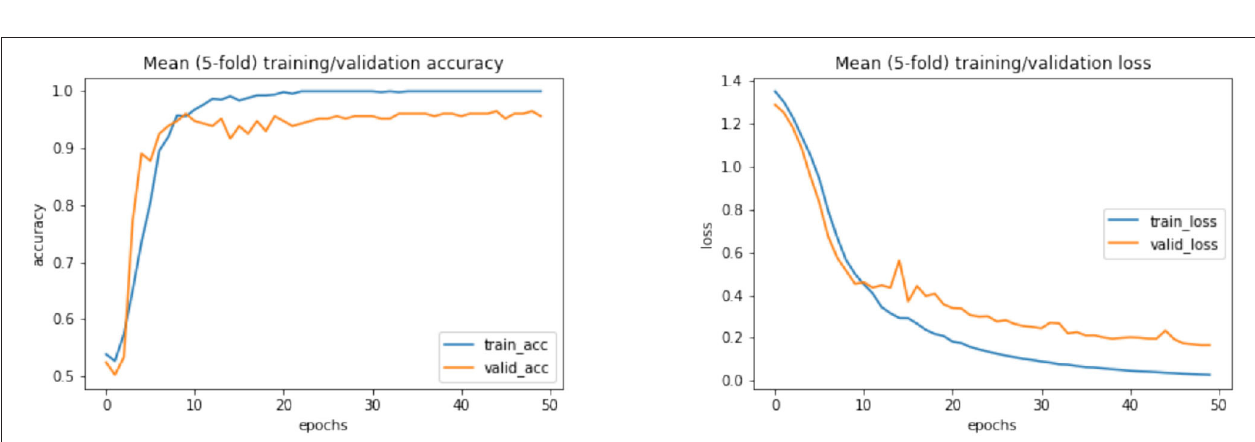
FIGURE 7 | Learning curves of CNN-LSTM method with ReLU activation function and z -score normalization. CNN, convolutional network; LSTM, long short-term memory.